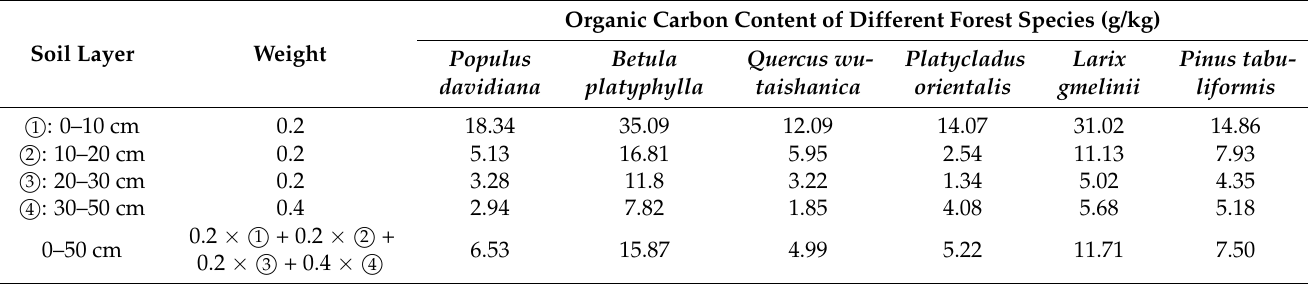
Table 1. Minimum SOC contents in different forest species based on a prior knowledge.